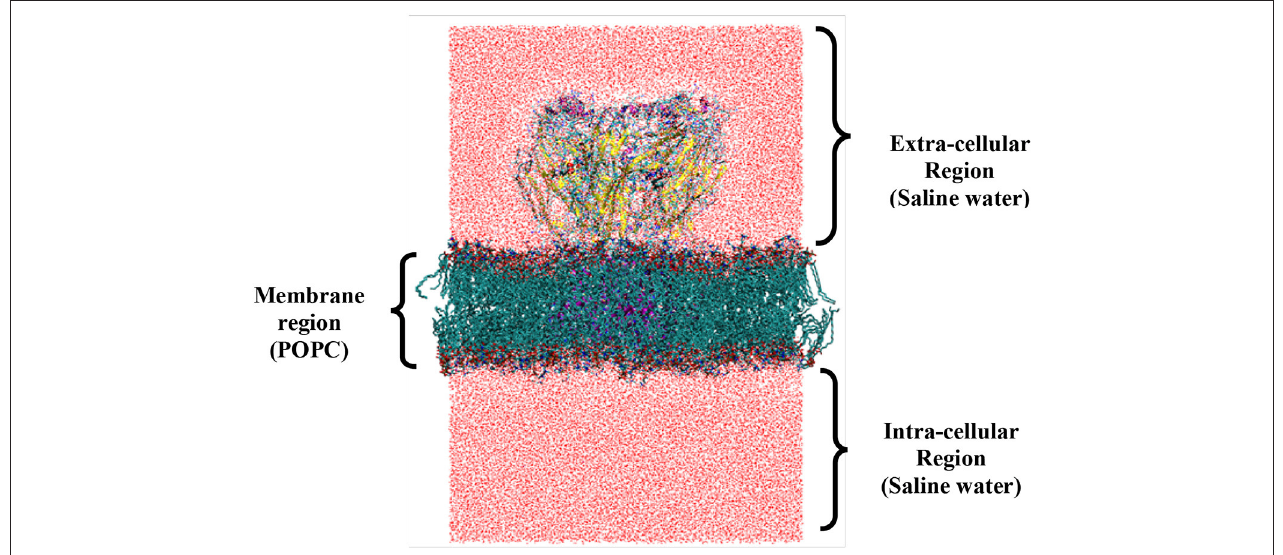
FIGURE 5 | System setup of full length ionophore complex for molecular dynamics simulation (closed state). The regions specify the different cellular compartments that are divided by the presence of membrane. At the center of the membrane, protein is embedded considering the proper placement of structural regions like ECD, TMD, and ICD to form the final setup. The number of atoms for (i) protein (15,688); (ii) lipids (25,896); (iii) waters (207,033); and (iv) ions (140) of system